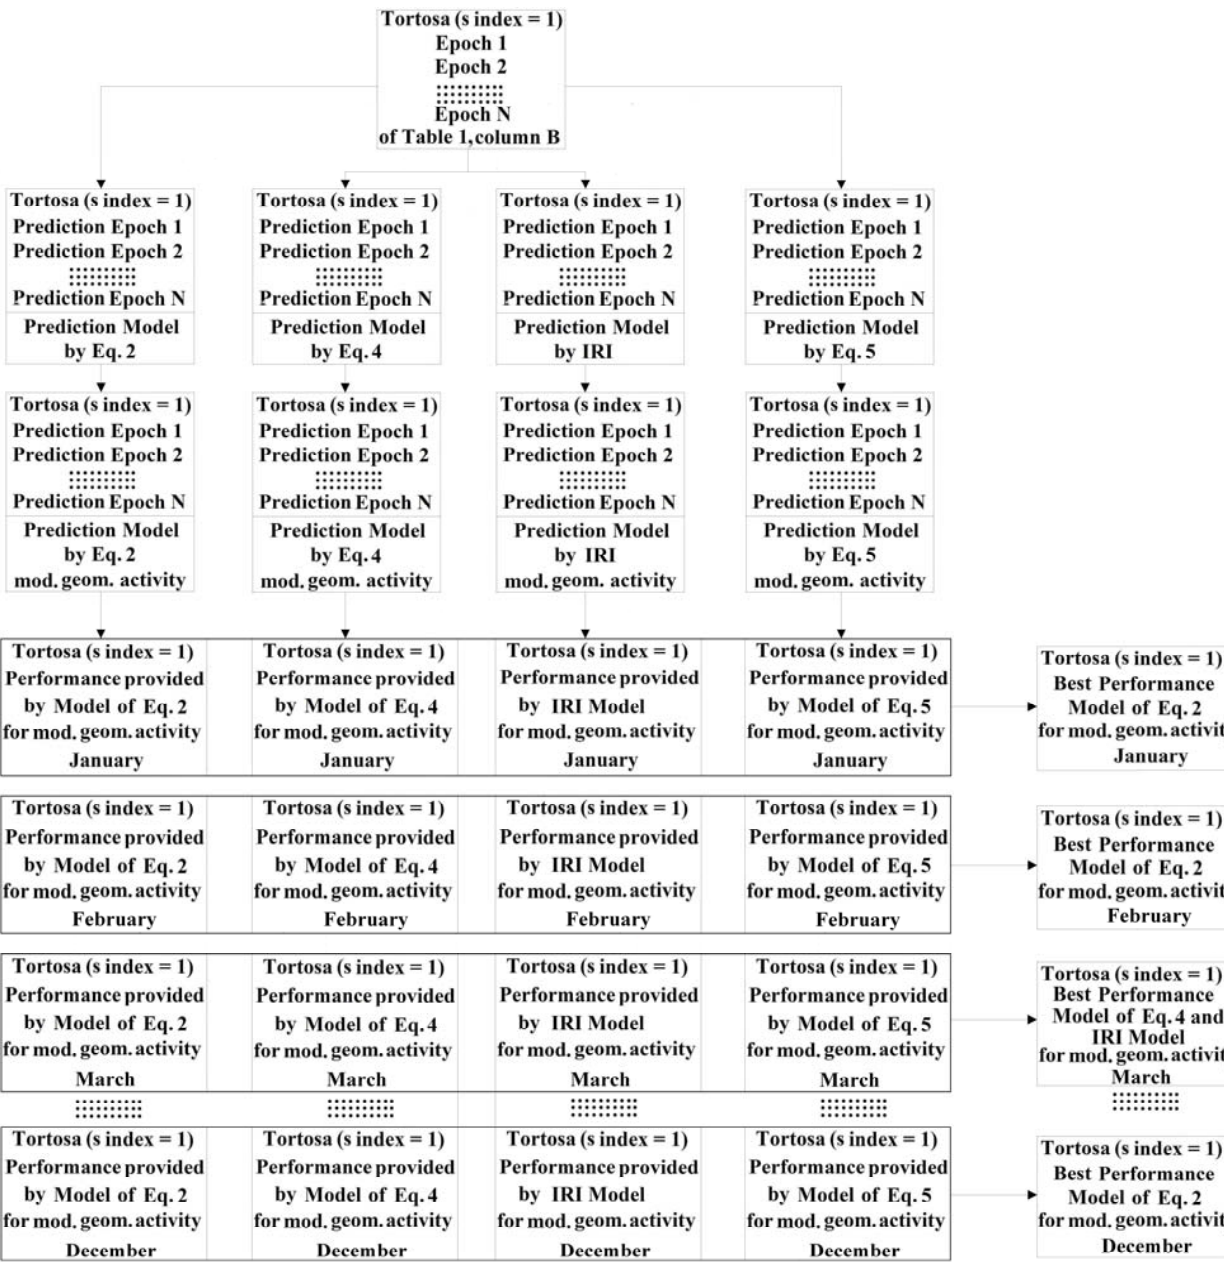
Fig. 2. Example of a flowchart describing the procedure followed to select the forecasting models providing the best performance in Tortosa under moderate geomagnetic